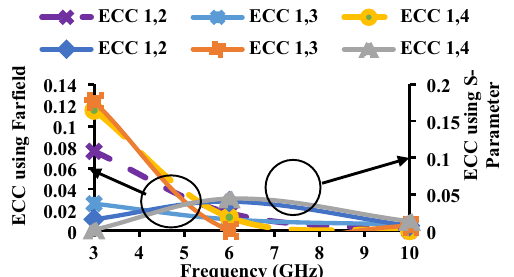
Figure 15. ECC of the proposed antenna.